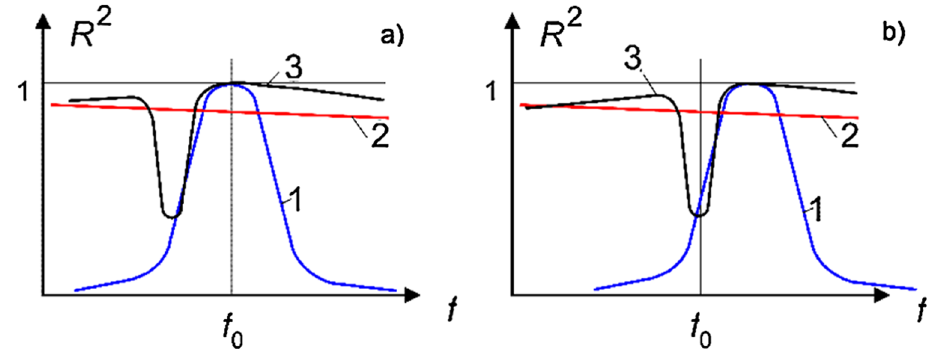
FIG. 4. (Color) Frequency dependence of the reflection coefficient of a plasma switch for (a) the condition of energy storage, and (b) for the condition of energy extraction. Frequency characteristics are shown of (1) the active section, (2) the diaphragm, and (3) total